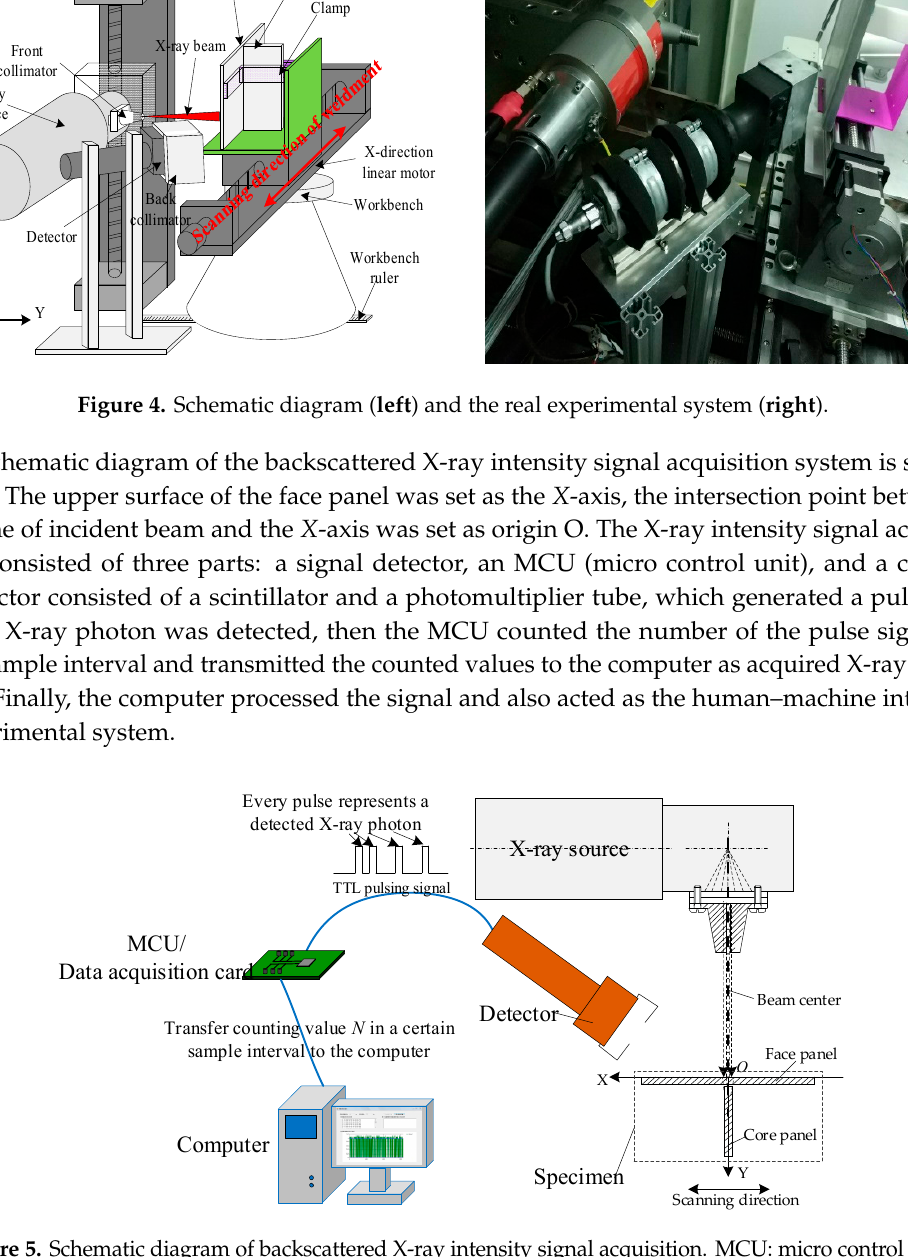
Figure 5. Schematic diagram of backscattered X-ray intensity signal acquisition. MCU: micro control unit.